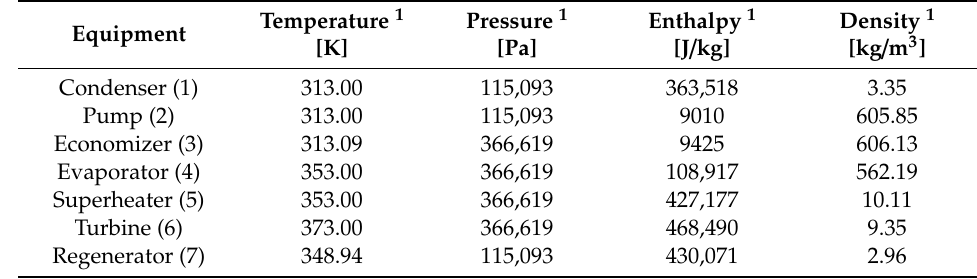
Table 2. R601 thermodynamic Figure 3. Cyclopentane T – S diagram. Table 1. Cyclopentane thermodynamic parameters.